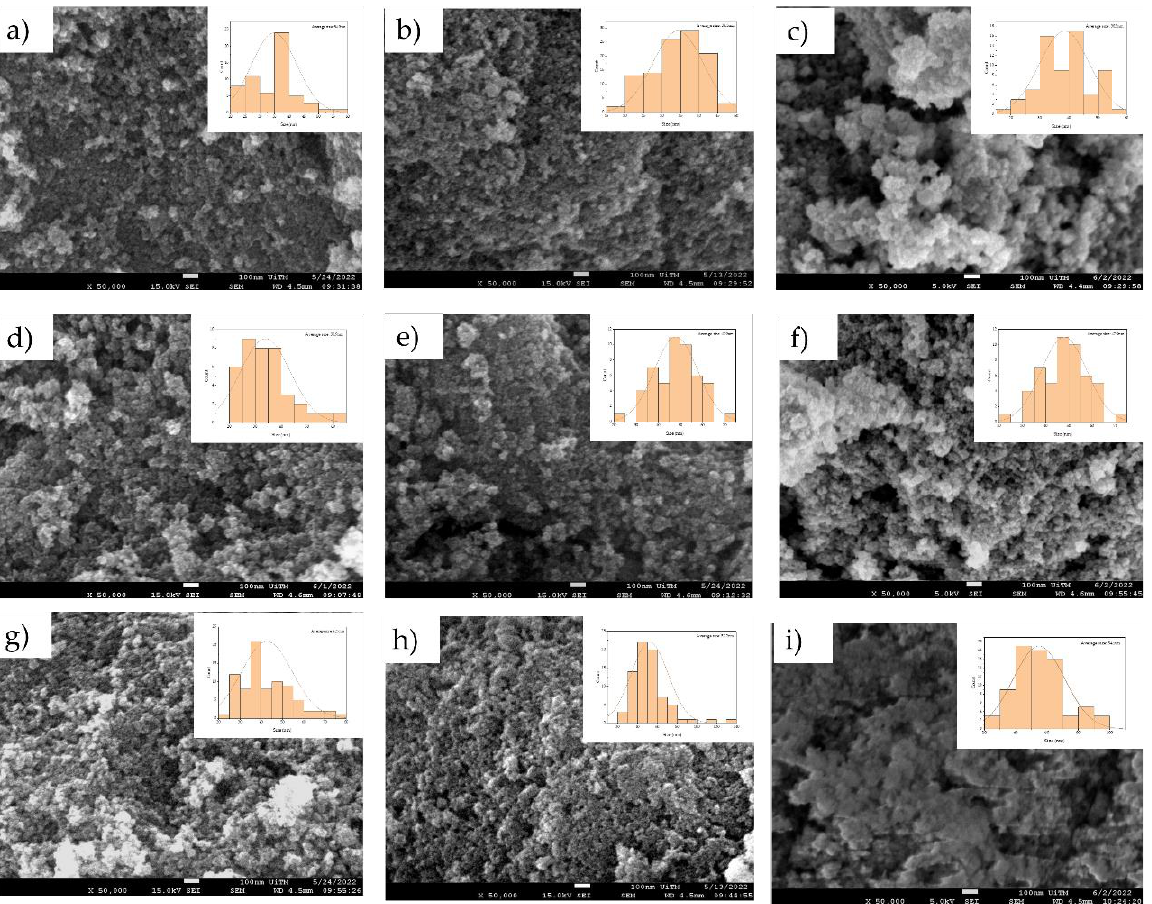
Figure 3. FE-SEM images of ( a ) 0.07 M CA-IONPs, ( b ) 0.07 M PVA-IONPs, ( c ) 0.07 M SDS IONPs, ( d ) 0.5 M CA-IONPs, ( e ) 0.5 M PVA-IONPs, ( f ) 0.5 M SDS-IONPs, ( g ) 1.0 M CA-IONPs, ( h ) 1.0 M PVA-IONPs and ( i ) 1.0 M SDS-IONPs.